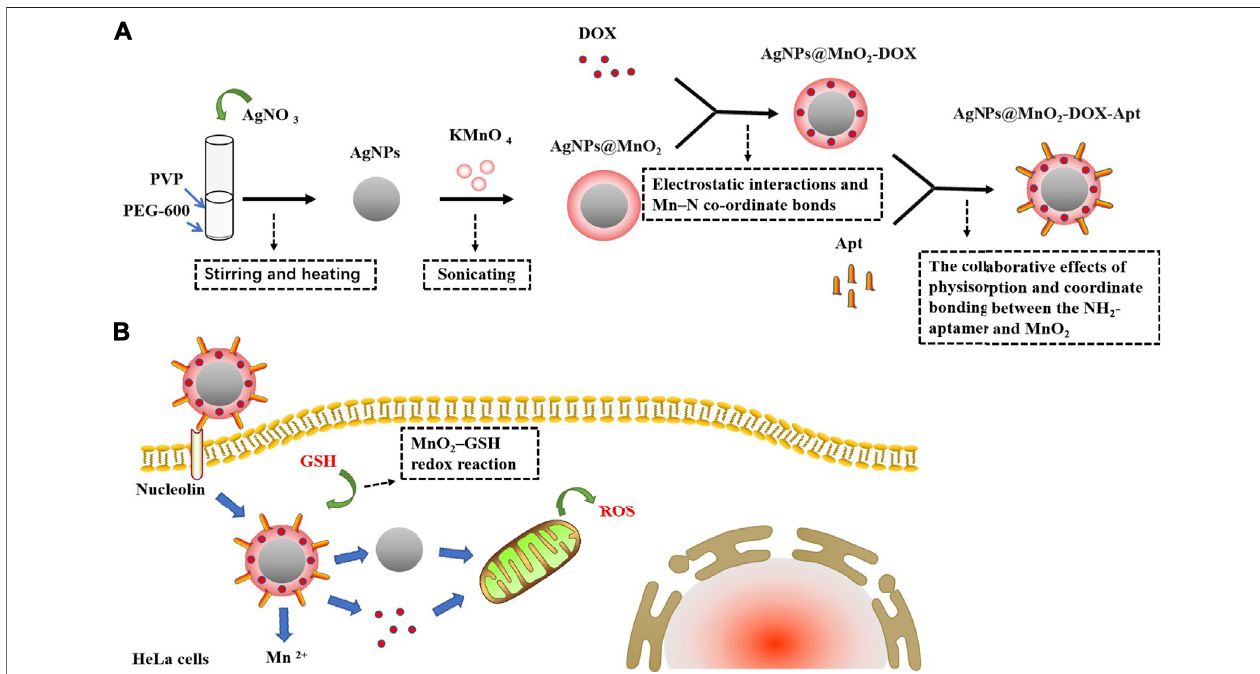
FIGURE3| Thesynthesis ofAgNPs@MnO 2 -DOX-Aptand pro-apoptoticmechanism. (A) AgNO 3 aqueous solutionisaddedintothe mixedliquor ofPEG-600 and PVP, and then AgNPs are synthesized under the conditions of stirring and heating. The AgNPs mixture added with KMnO 4 is sonicated to synthesize AgNPs@MnO 2 core – shell nanostructure for MnO 2 -modi fi ed AgNPs, and the MnO 2 nanosheets can load DOX via electrostatic interactions and Mn – N co-ordinate bonds. Finally, AgNPs@MnO 2 -DOX-AptissynthesizedbyfunctionalizingtheAptontotheMnO 2 nanosheetsviathecollaborativeeffectsofphysisorptionandcoordinatesbonding between the NH2-Apt and MnO 2 . (B) AgNPs@MnO 2 -DOX-Apt can enter HeLa cells through nucleolin receptor-mediated endocytosis, and release AgNPs and DOX under the response of MnO 2 – GSH redox reaction which could induce ROS-mediated